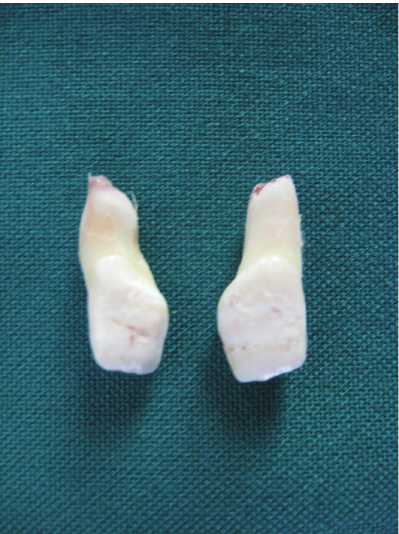
Figure 5: Labial aspect of mesiodens showing the dilaceration and indentation on crown of mesiodens.